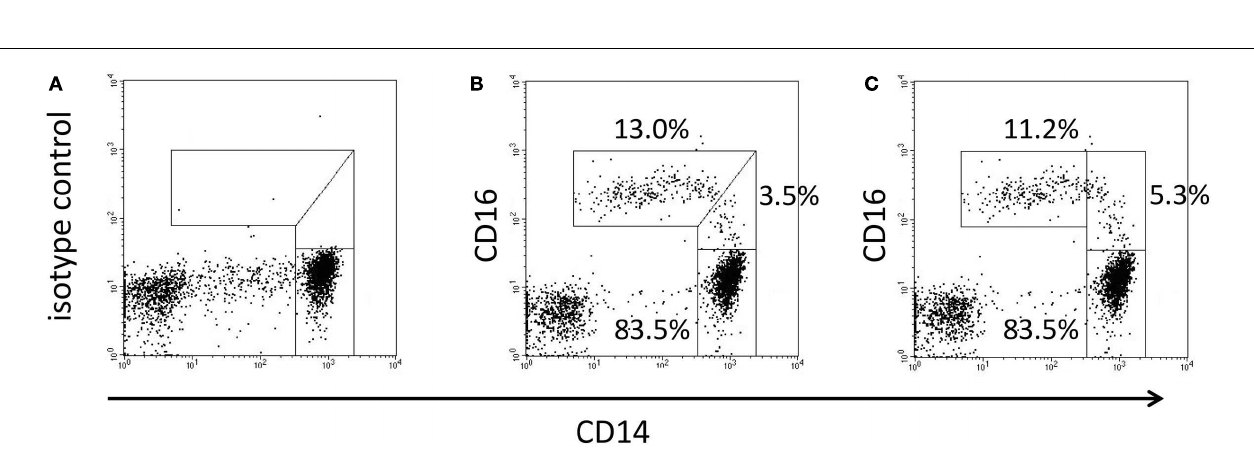
and non-classical monocytes is done with an oblique line to the right of the cloud of non-classical events. In (C) a straight vertical line is placed to the left hand end of the classical